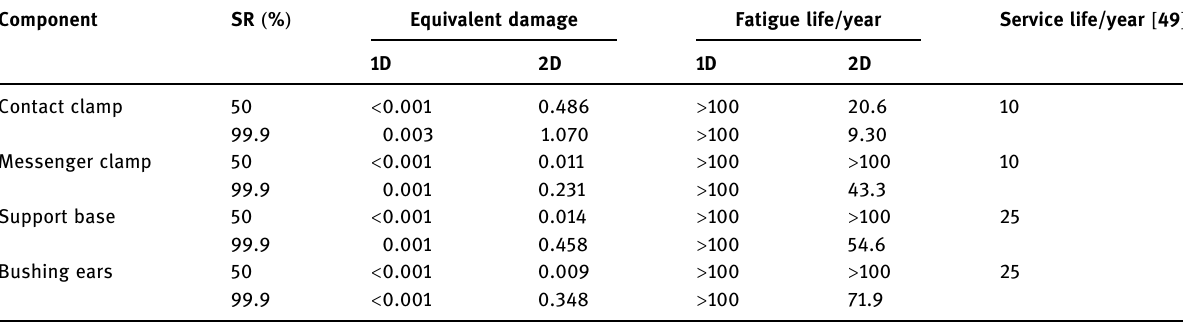
Table 11: Fatigue damage and life estimation of catenary connection components Component SR ( % ) Equivalent